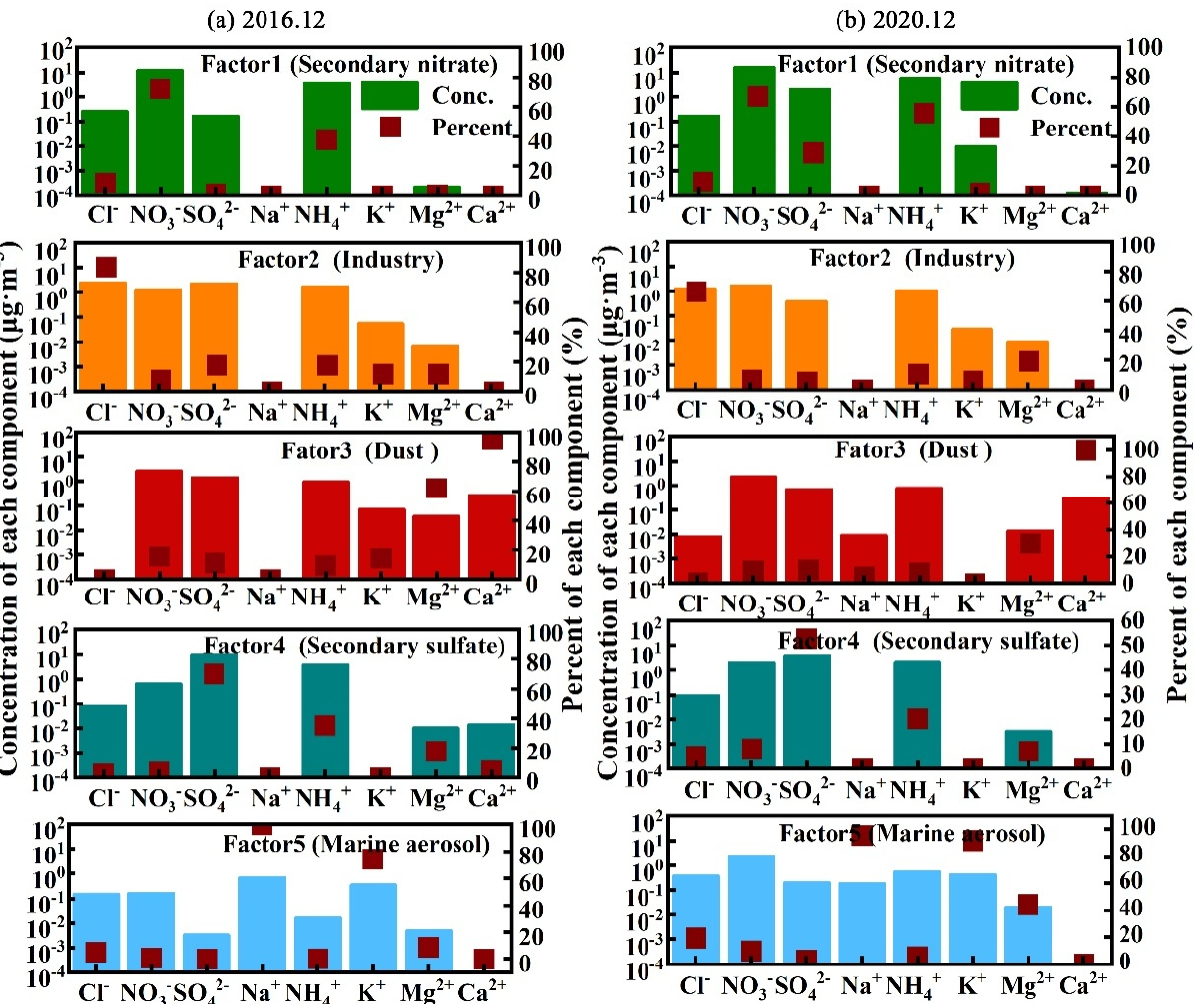
Figure 7. The five source profiles in December of different years: ( a ) December 2016; ( b ) December